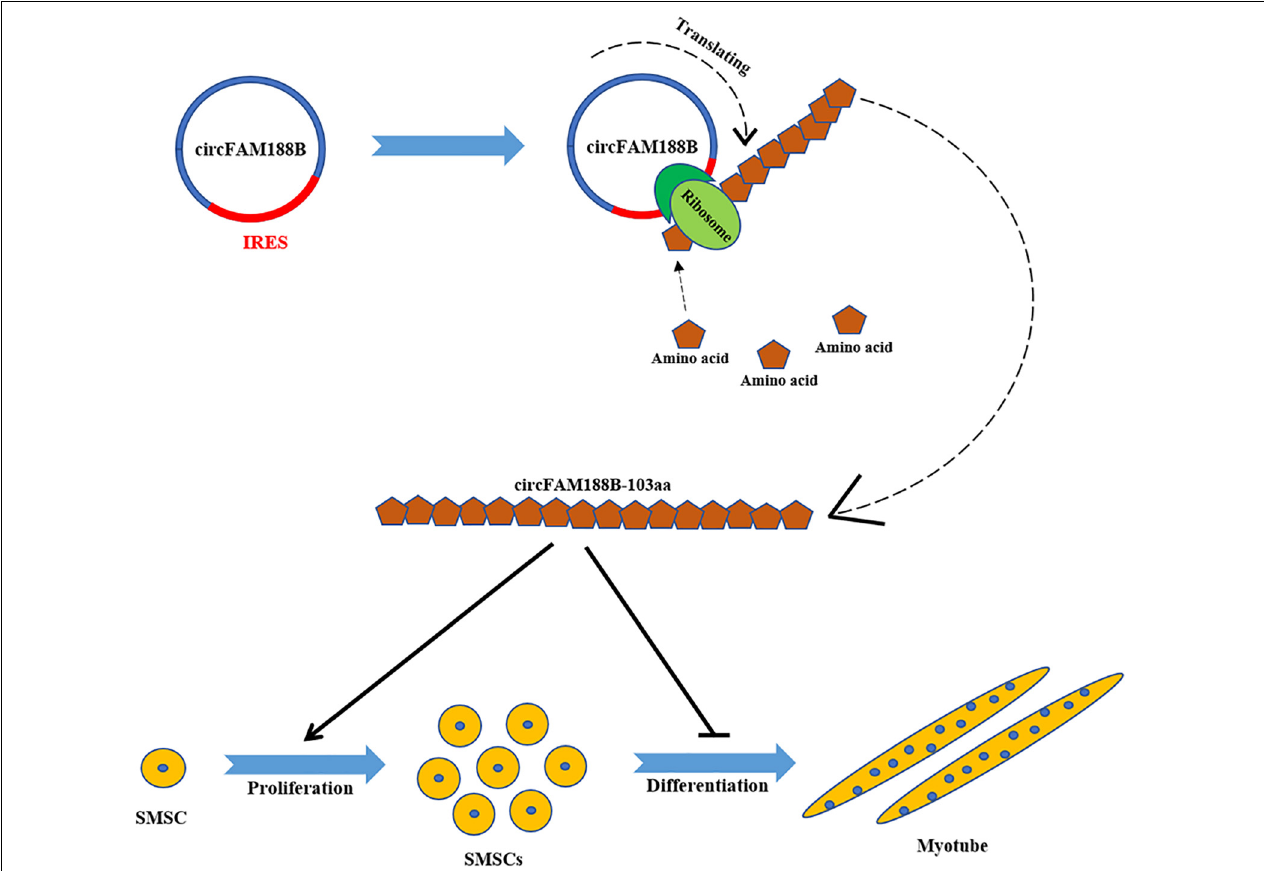
FIGURE 9 | A schematic model of CircFAM188B regulates chicken SMSC proliferation and differentiation. IRES drives a novel circular RNA circFAM188B translation into protein circFAM188B-103aa to promotes the proliferation and inhibits the differentiation of chicken